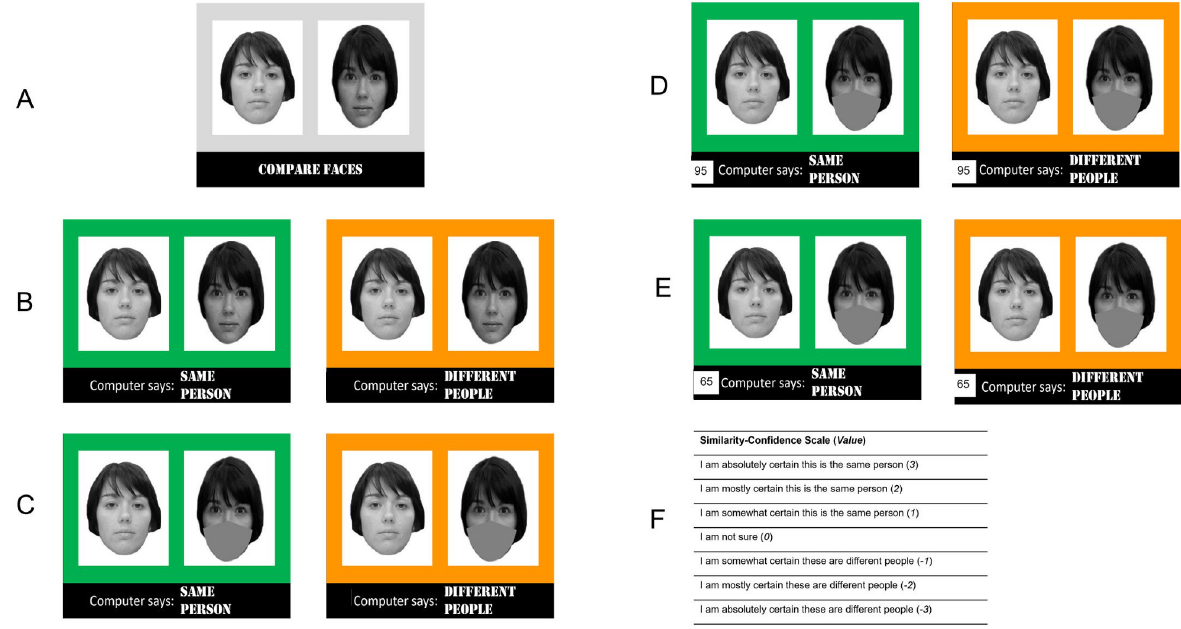
Fig 1. Example of face pair stimuli (from the Glasgow Face Matching Task (GFMT) [3]) and experimental conditions used. After viewing each stimulus, reviewers were asked to rate the similarity of the faces. A . Study 1 and 2 control condition. Reviewers were presented with pairs of faces without any additional information. B . Study 1 no mask condition. Face pairs were presented with along with prior algorithm identity decisions communicated by text and color (“SAME PERSON”/green and “DIFFERENT PEOPLE”/orange). C . Study 1 mask condition. The right face image in each pair was digitally altered with a digital neutral gray mask covering the lower portion of the face. Prior identity decisions were presented as in B. D and E . Study 2 presentation of algorithm accuracy information. The number in the lower left of each face pair reminded reviewers of algorithm’s accuracy as explained at the beginning of the task. Prior identity decisions were presented as in B and C. F . Similarity-confidence scale reviewers used to rate each face pair in Study 1 and Study 2.